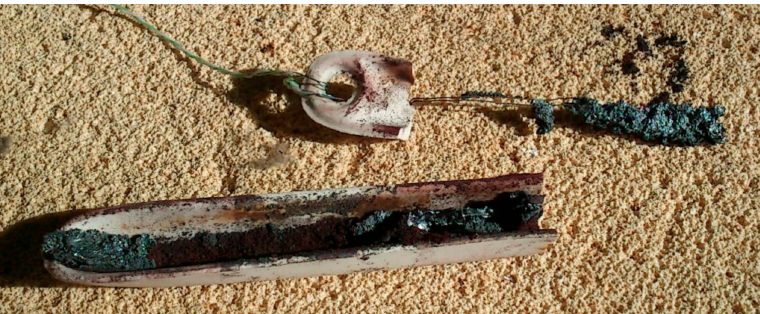
Figure 16. Sample once treated with concentrated solar energy